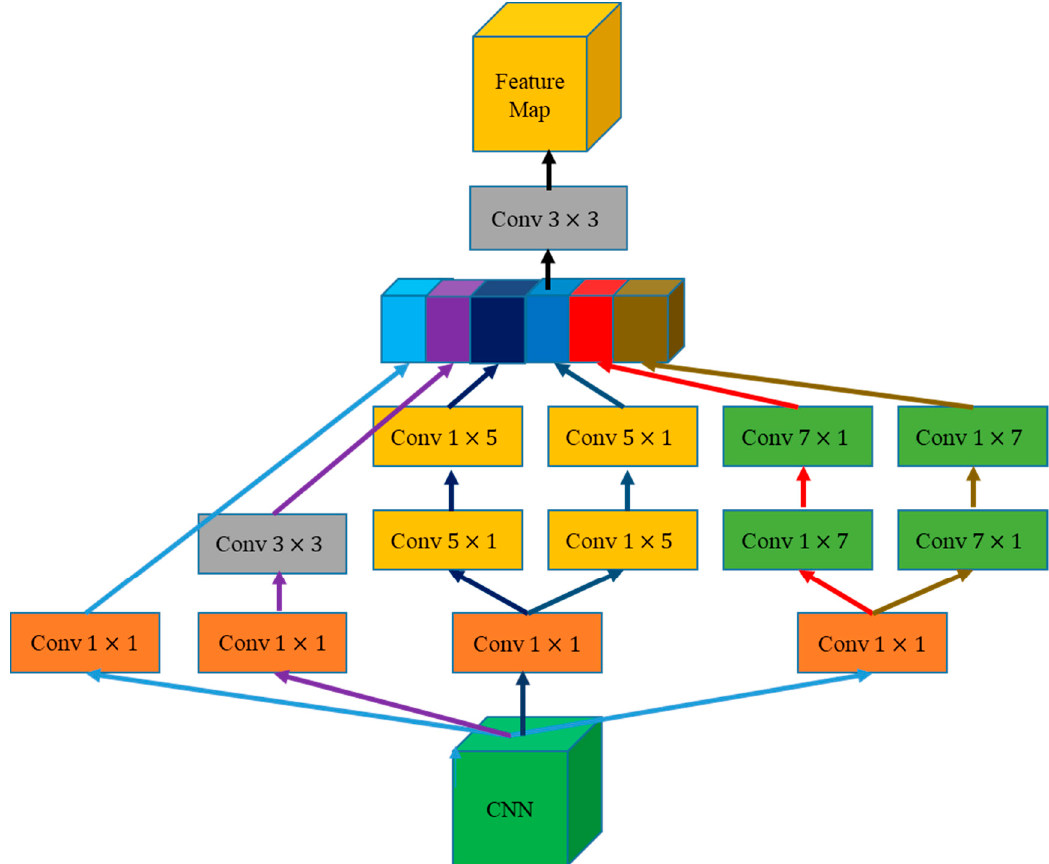
Figure 5. MCE architecture. The green box is the input feature map, the yellow box is the output feature map, the rectangle is the convolution operation of different sizes of convolution kernel, and the colored box is the multiscale feature map in series according to the channel.